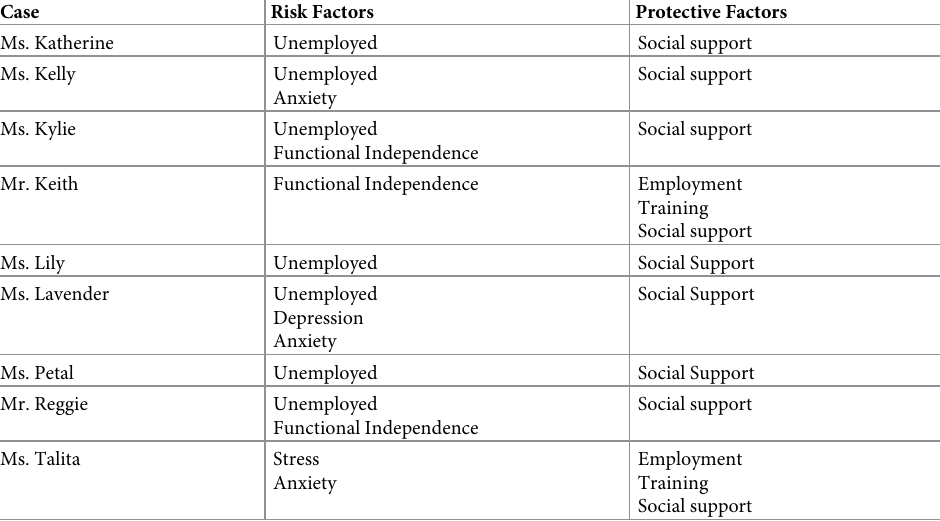
Table 5. Risk and protective factors ( N =